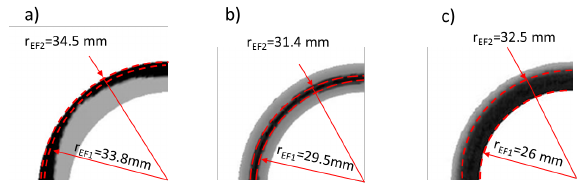
Figure 17: Determination of the gasket’s effective radius, a) stan- dard gasket, b) gasket with symmetric grooves, c) gasket wit exter- nal groove